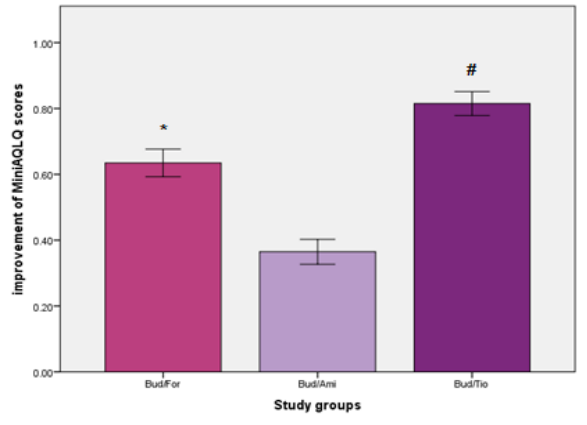
Figure 8. Comparison of groups according to extent of change in the MiniAQLQ scores during the second four weeks of study *: significant difference compared to second group #: significant differences compared to first and second groups Bud/For (First group): Budesonide/Formoterol Bud/Ami (Second group): Budesonide/Aminophylline Bud / Tio (Third group):